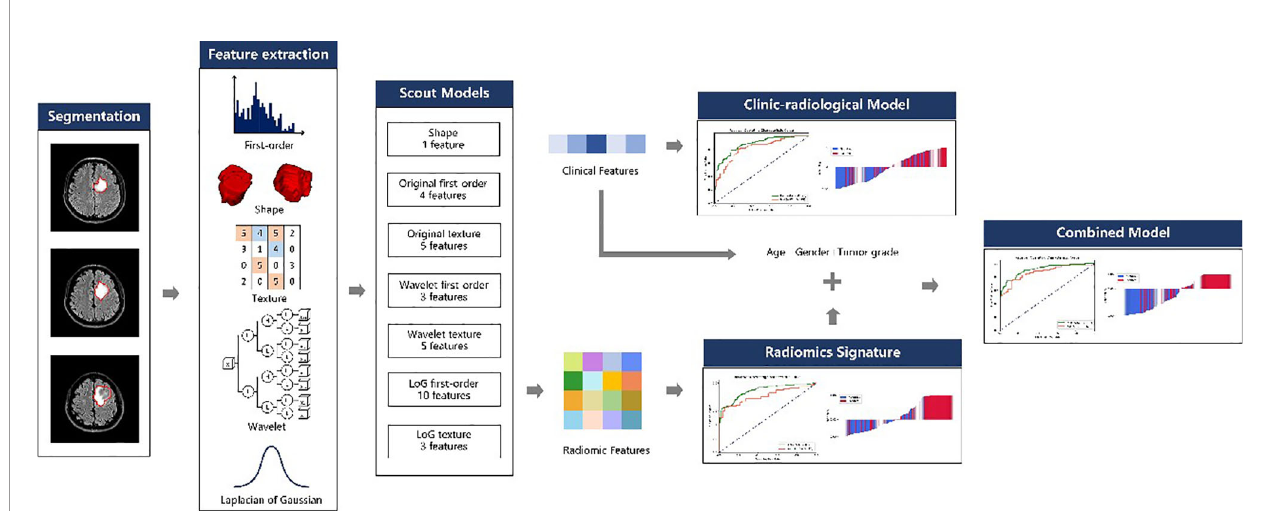
FIGURE 1 | Radiomics work fl